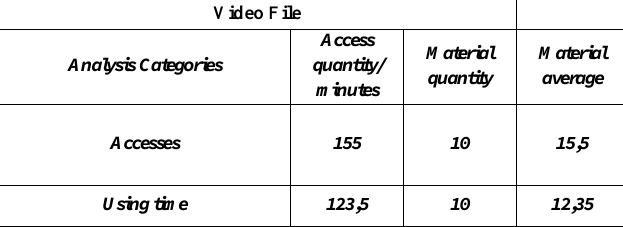
Table 2. Video results